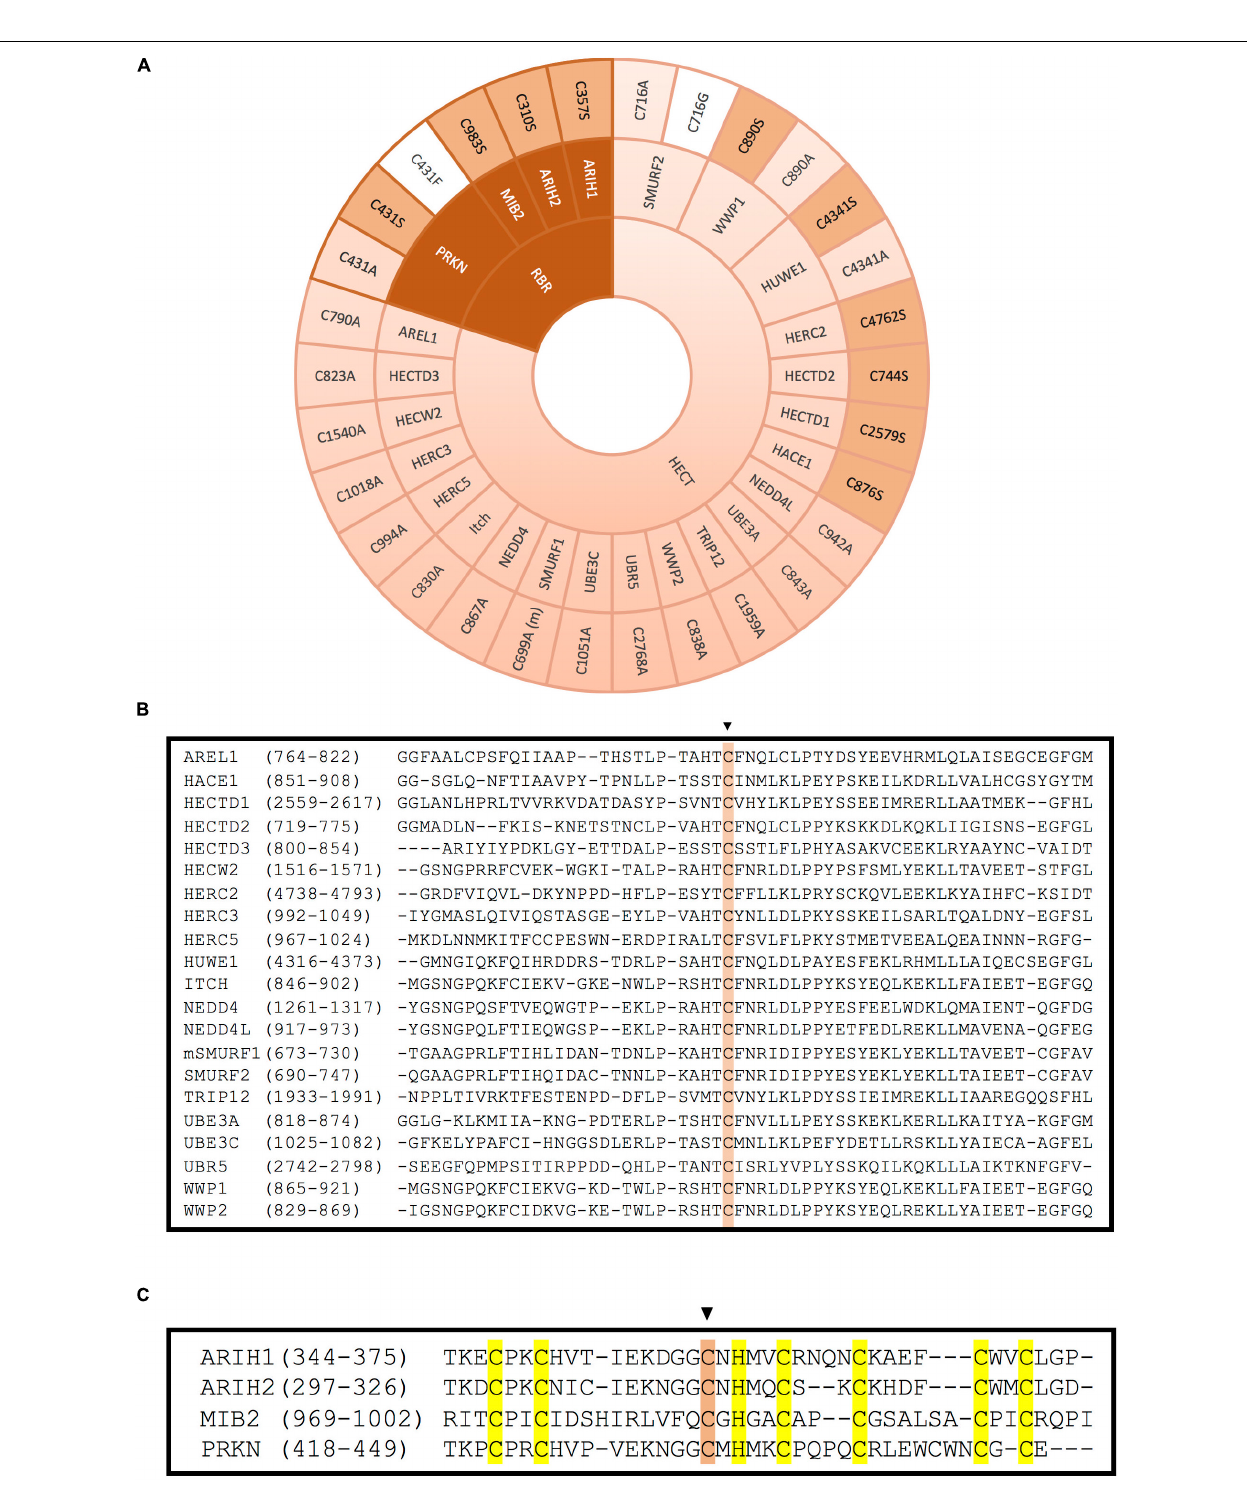
Frontiers in Cell and Developmental Biology |